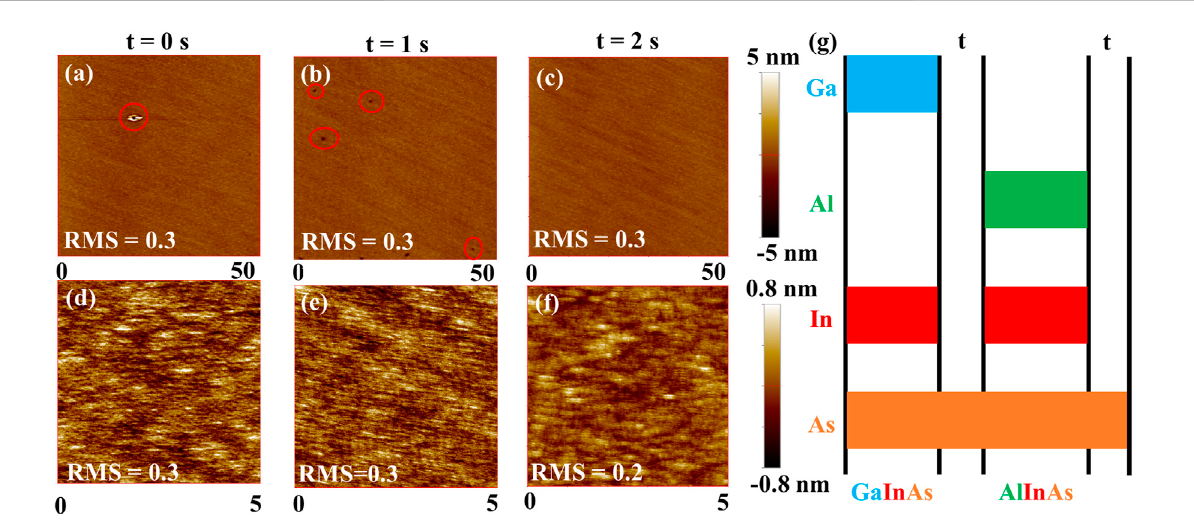
FIGURE 4 (A – F) : AFM images of the surface of 60-periods 6 nm-InGa 0.463 As/2 nm-InAl 0.489 As/InP superlattices in different interruption times at Ts = 420 ° C (up: 50 μ m × 50 µm scan area; down: 5 μ m × 5 µm scan area), estimated root mean square (RMS) of surface roughness is demonstrated. (G) The shutter sequence of the superlattices